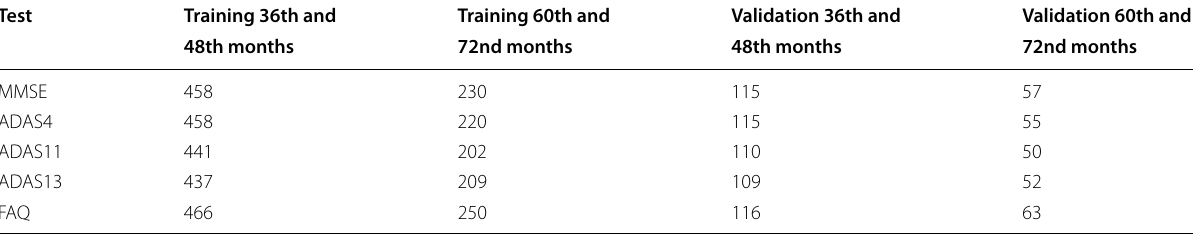
Table 3 Number of observations for training and validation of sequence prediction RNNs Test Training 36th and Training 60th and Validation 36th and Validation 60th